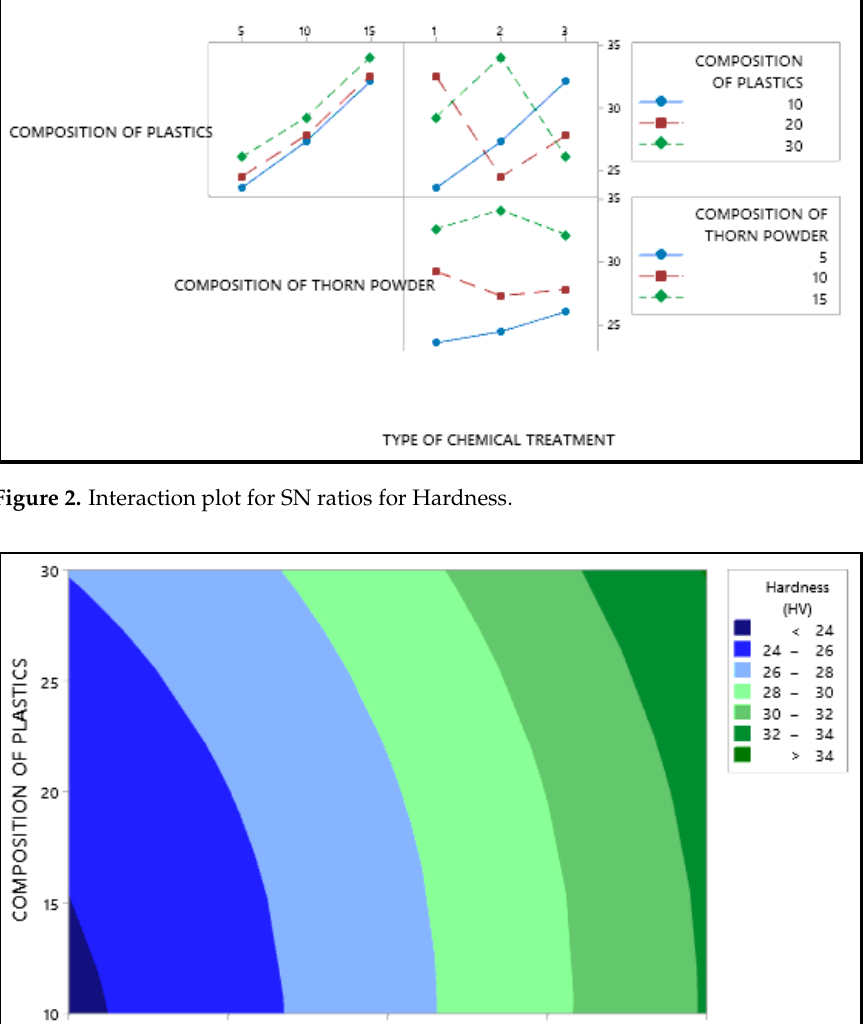
Figure 1. Effects chart for Hardness.